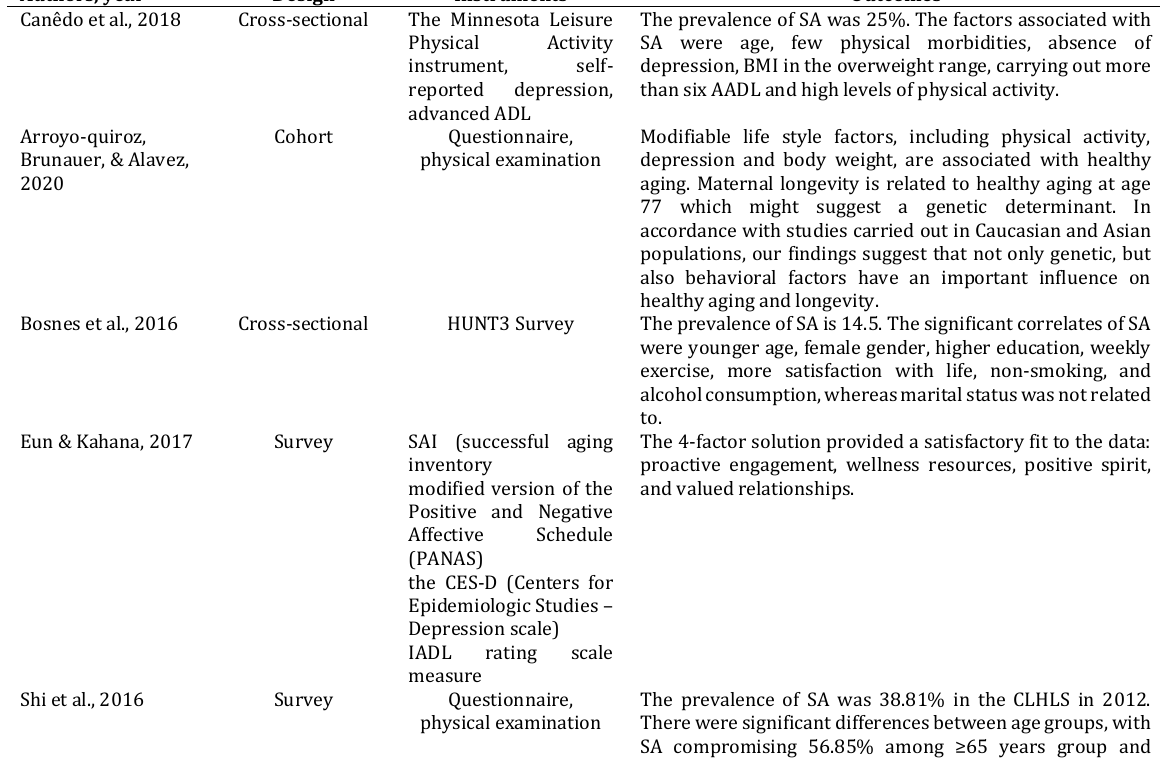
Table 2 Summary of selected study (design, measure, outcome) Authors,